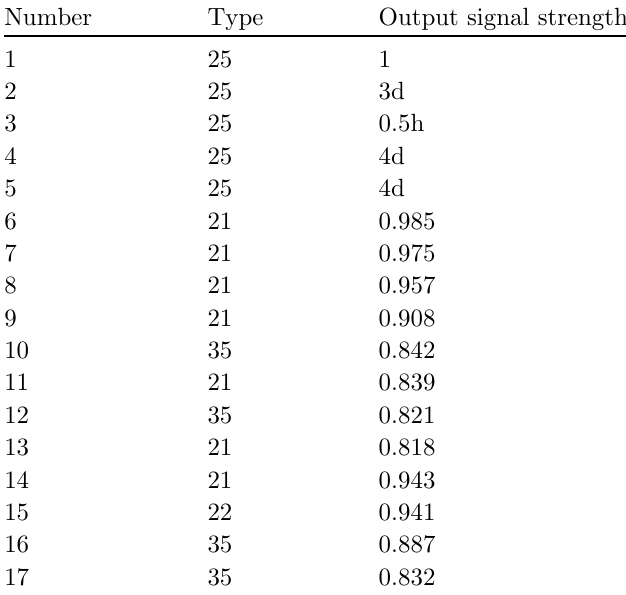
Table 2. The signal strength of cross-regional mangosteen cold chain logistics